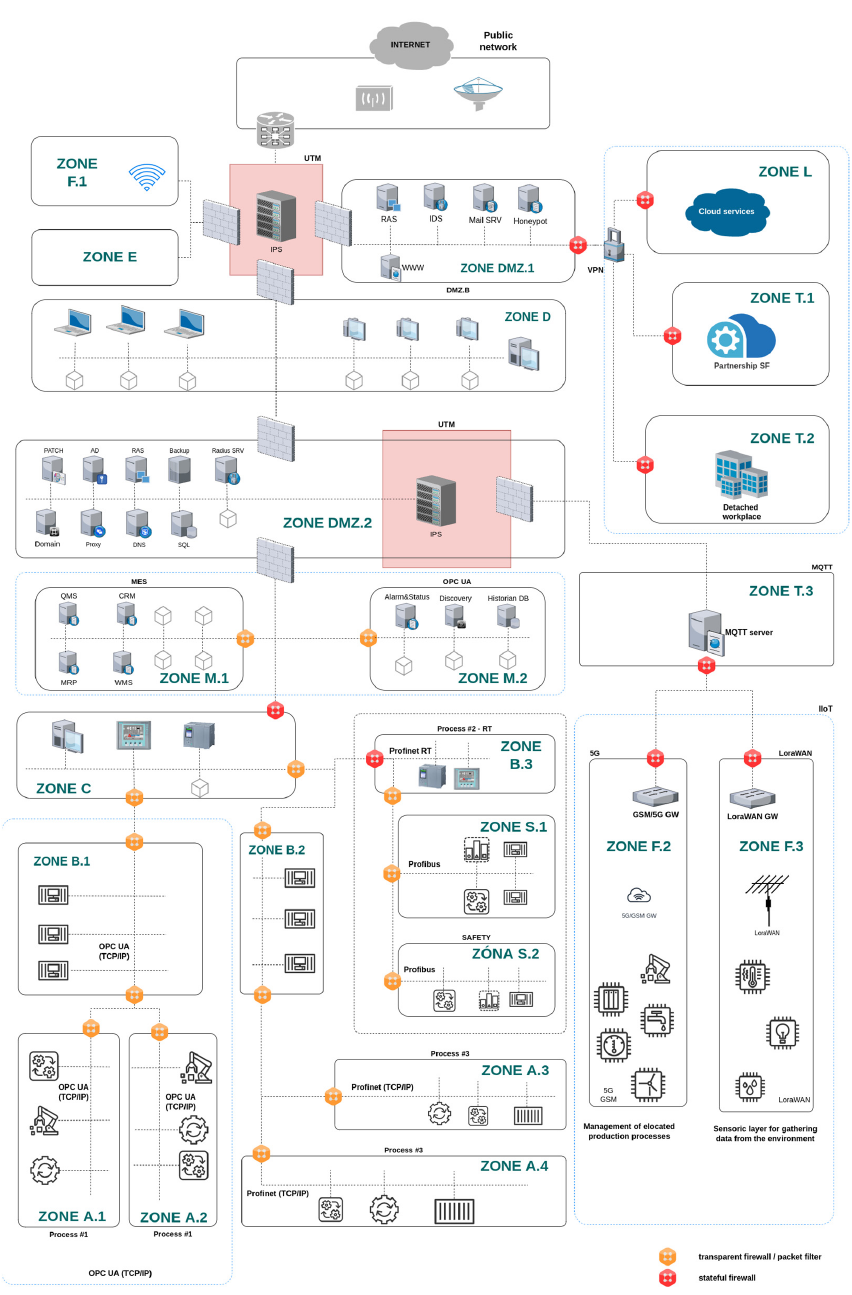
Figure 17. Implementation of the zonal security principle in the Smart Factory cybernetic system.